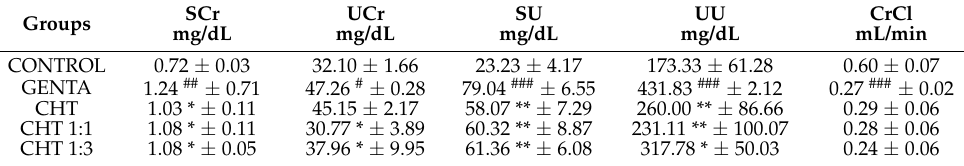
Table 6. Renal function parameters in rat gentamicin-induced acute kidney injury. Groups